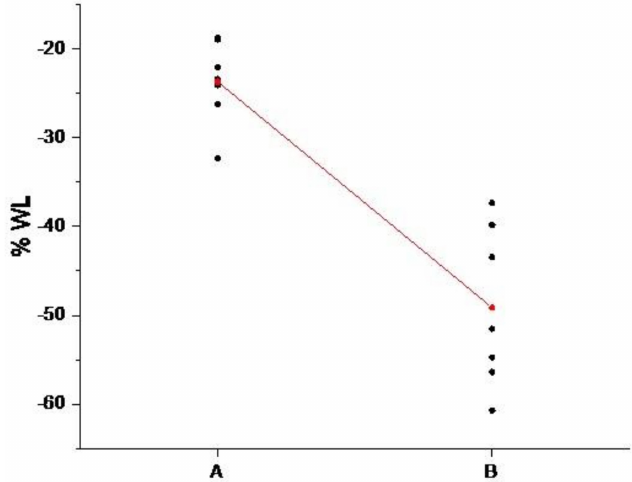
Figure 4. Individual value plot of the % weight loss of sample A and sample